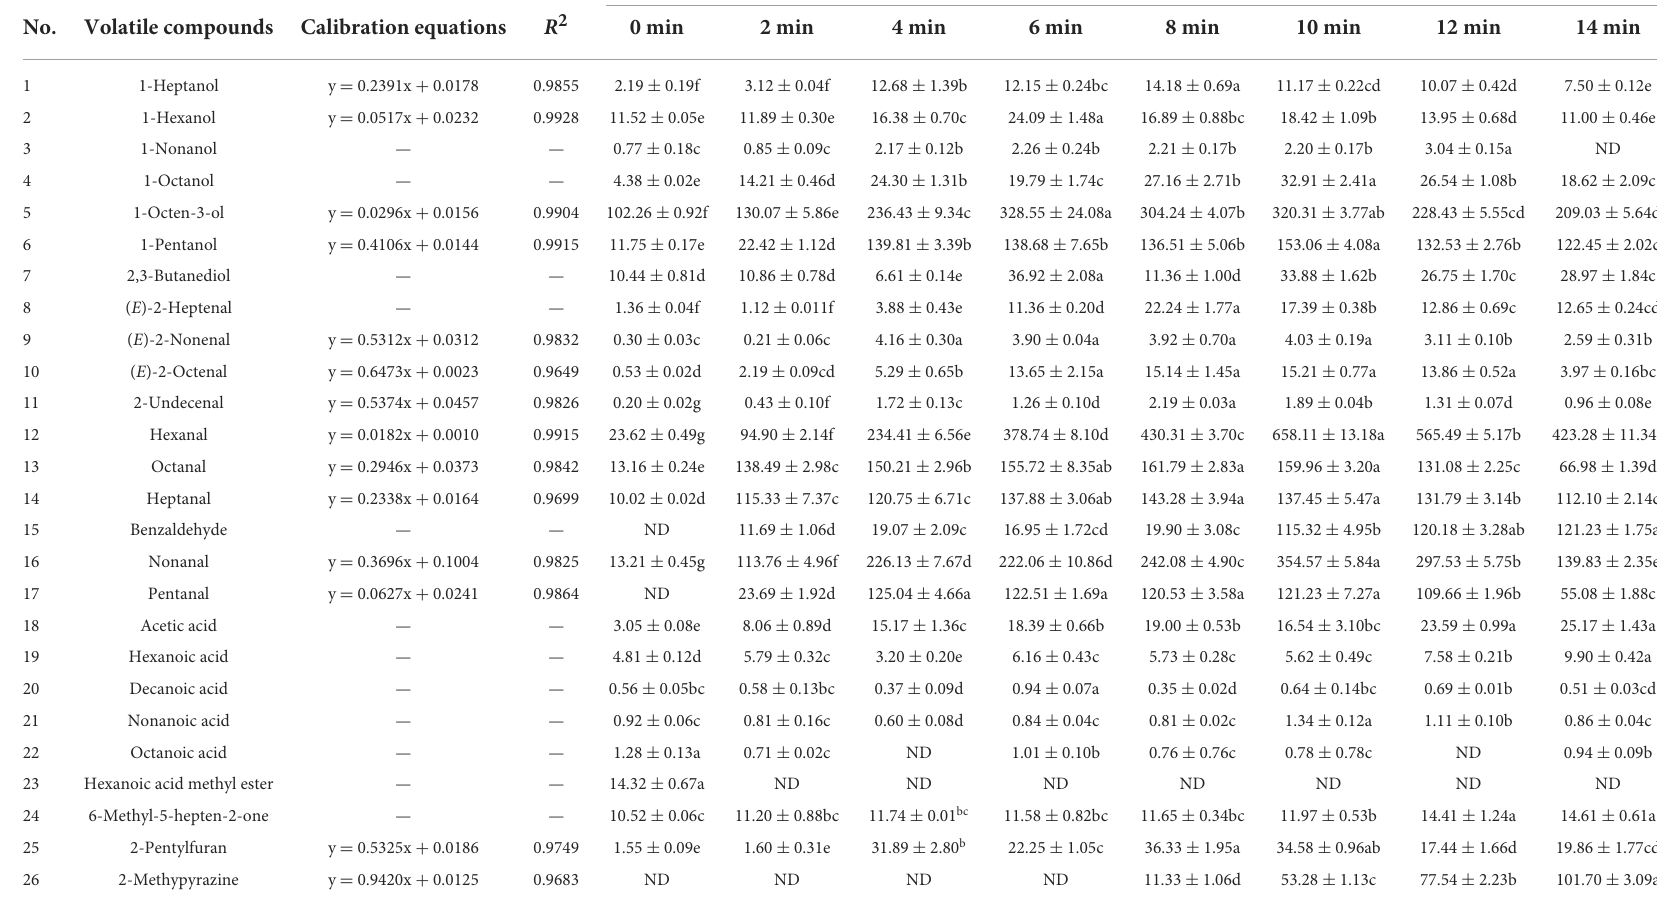
TABLE 2 Quantitation analysis of aroma compounds in roasted Tan mutton during the roasting